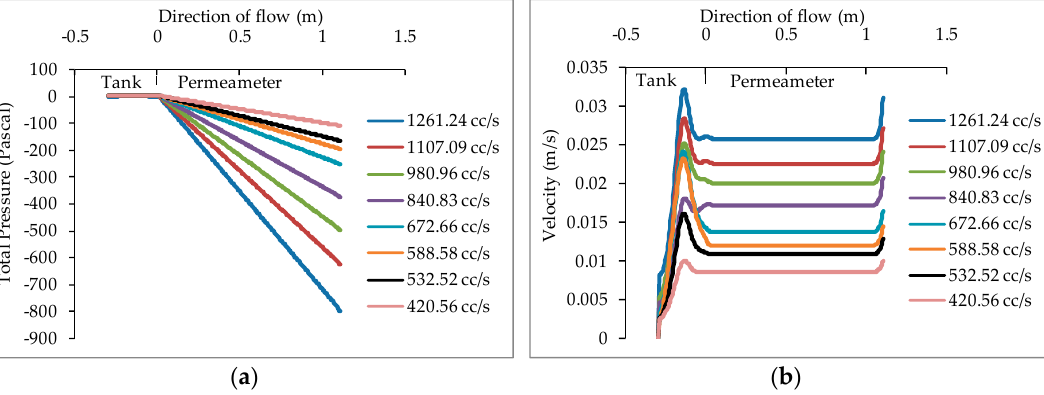
Figure 8. The values of ( a ) the total pressure and ( b ) the velocity in the direction of the flow subjected to different discharges for 41.59 mm media packed with 43.62% porosity.